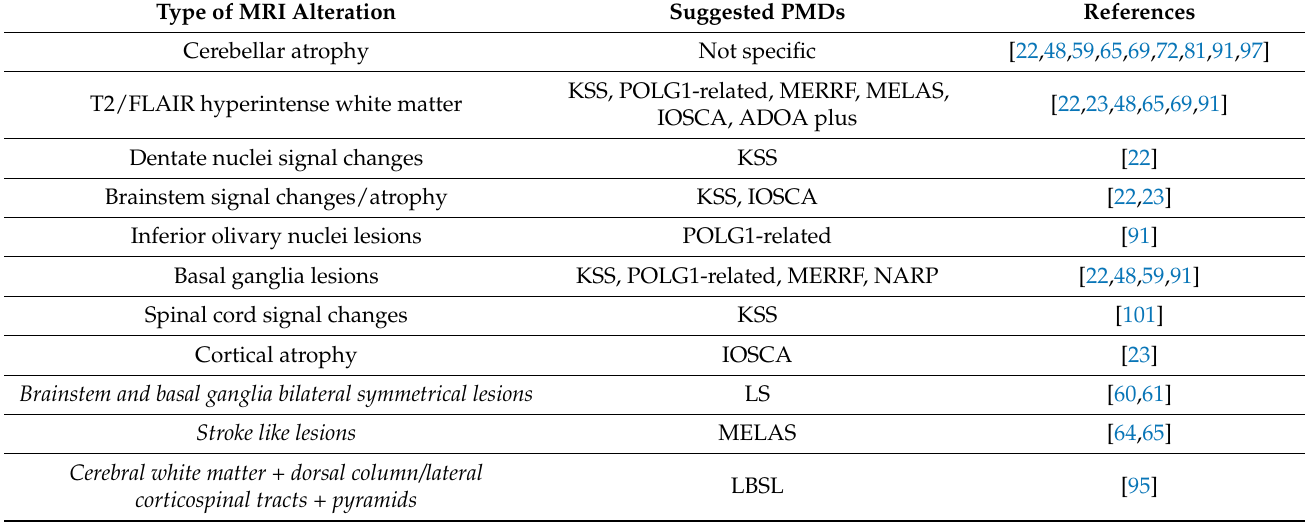
Table 4. Neuroimaging alterations suggestive of mitochondrial ataxia and specific